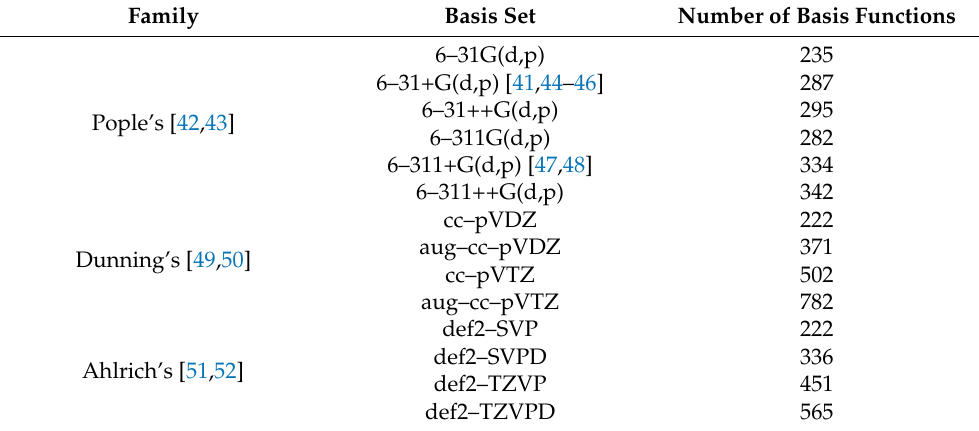
Table 4. List of basis sets tested within the paper. Family Basis Set Number of Basis